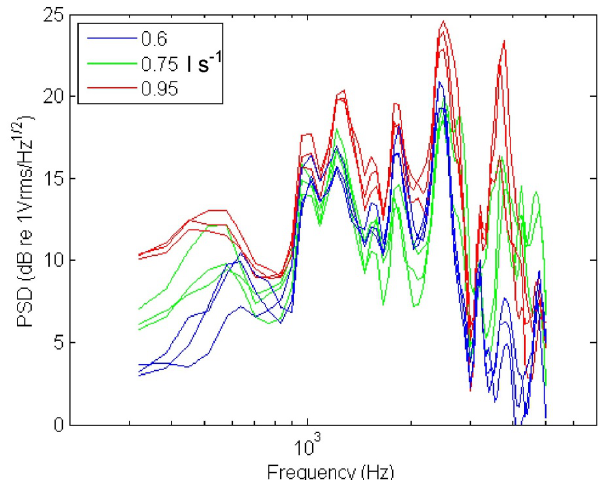
Fig. 8. Spectrum of the voltage output from a miniature hydrophone (ITC 1089d) mounted approximately 5cm from the end of the plunging sheet. There are 9 spectra shown in the plot consisting of three replicas for three different flow rates as indicated in the legend. The variation of the spectra with frequency is a function of both resonances within the tank and variation in the sound radiated by the bubble plume. Despite variability within an ensemble for a fixed flow rate, distinct differences in the spectra can be seen be- tween flow